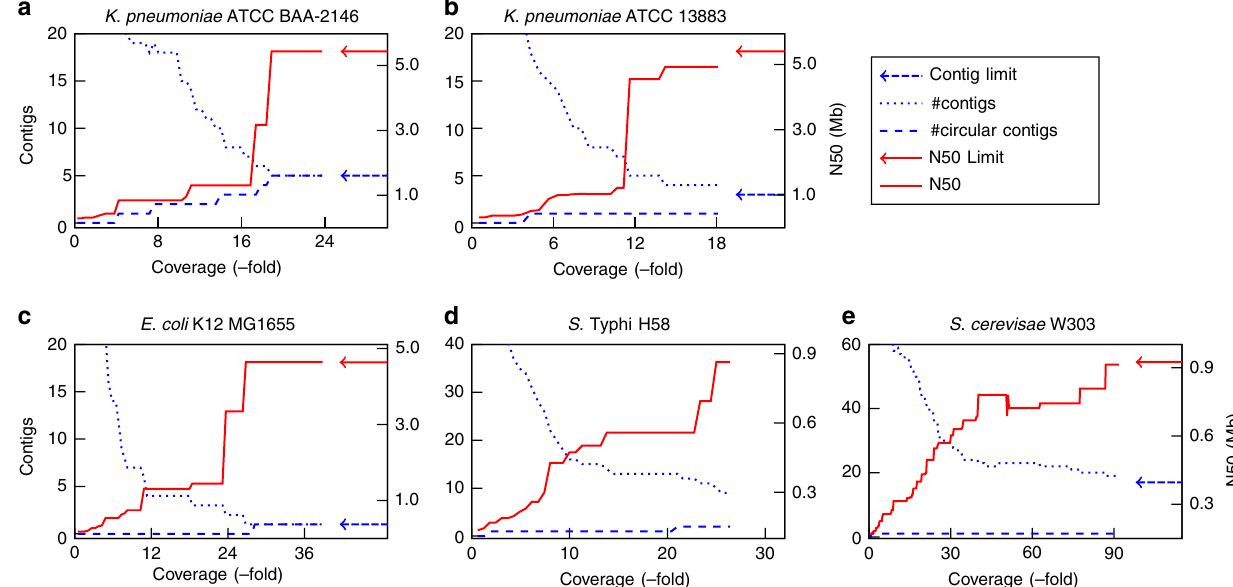
Figure 2 | Assembly statistics during real-time scaffolding. The plots show N50 statistics, number of contigs, and number of circular contigs against the amount of nanopore sequencing data for ( a ) K. pneumoniae ATCC BAA-2146, ( b ) K. pneumoniae ATCC 13883, ( c ) E. coli , ( d ) S. Typhi H58, and ( e ) S. cerevisae